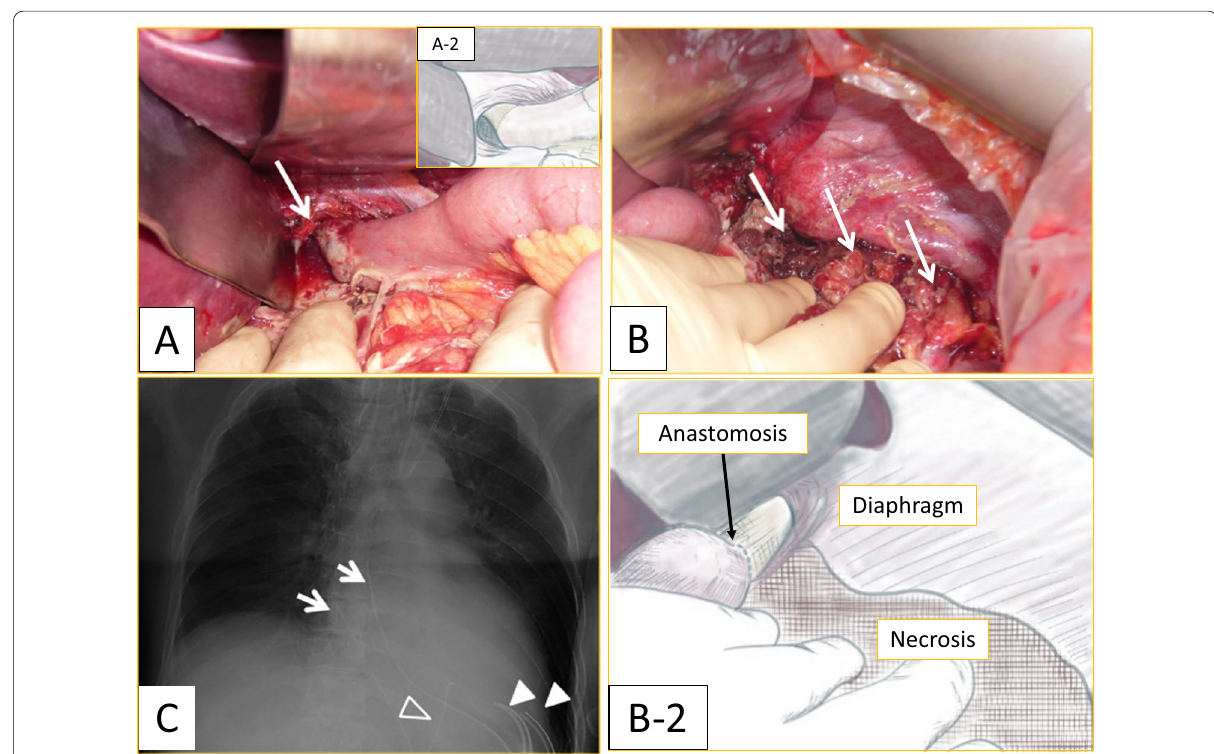
Fig. 6 Operative findings. A The anastomosis (arrow) is intact. A-2 A schema of figure A. B Continuous inflammation and necrotic tissue are observed from the pancreatic tail to the anastomosis site (arrow). B-2 A schema of figure B. C Drain in the mediastinum (arrow), subphrenic area ( ▲ ), and the anastomosis site ( △ )